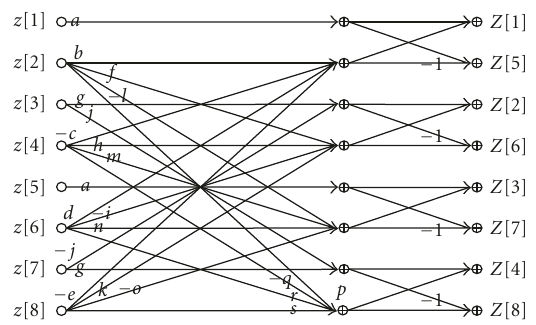
Figure 4: Fast algorithm for the transform-domain DCT-to-HT